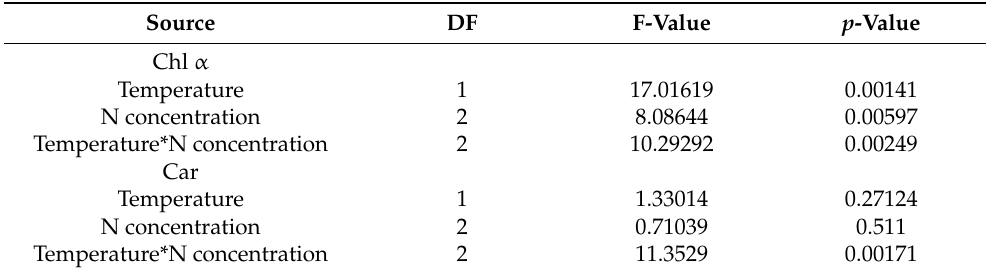
Table 6. Results of two-way ANOVA for chlorophyll α (Chl α ) and carotenoids (Car) of S. horneri under LN, IN, and HN, treated by CT and ET.